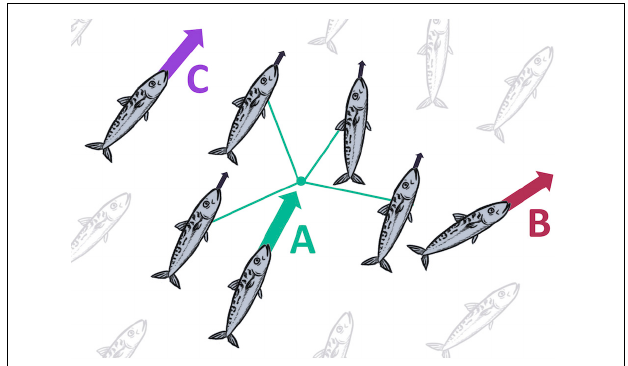
FIGURE 2 | Interaction rules that form the basis of a “Boids” model (Reynolds, 1987), often used in collective behavior IBMs. Rules are (A) attraction to mean position of nearest neighbors; (B) avoidance of other individuals at close proximity; (C) alignment with